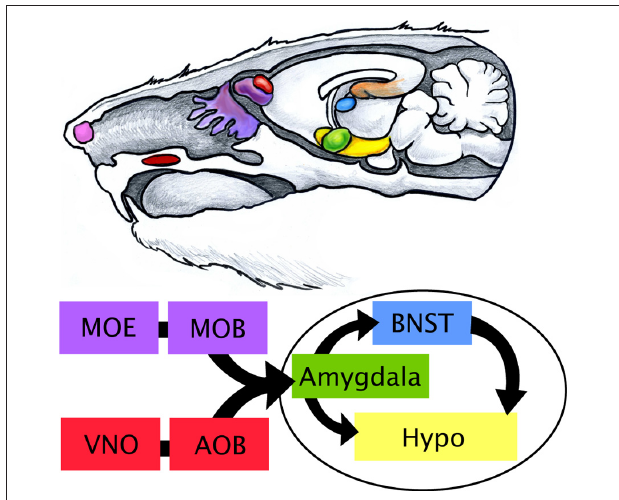
FIGURE 2 | Limbic processing of olfactory information in the rodent. The rodent limbic system is highly influenced by olfactory cues received by the main olfactory epithelium (MOE, purple) and vomeronasal organ (VNO, red). The Grueneberg ganglion (pink), which senses stress in conspecifics, is depicted in the tip of the rodent nose. The VNO, located on the palate, of the mouth detects non-volatile or lipophilic chemicals that are channeled by the tongue through a pore in the roof of the mouth. Volatile chemical scents are more readily aerosolized and travel further back into the nasal cavity to reach the MOE on the turbinates. Projections from sensory neurons in the VNO and MOE are received in the accessory olfactory bulb (AOB) and main olfactory bulb (MOB), respectively, located in the brain. Signal is then passed to other structures of the limbic system including the amygdala (green), bed nucleus of stria terminalis (BNST, blue), and hypothalamus (Hypo, yellow).